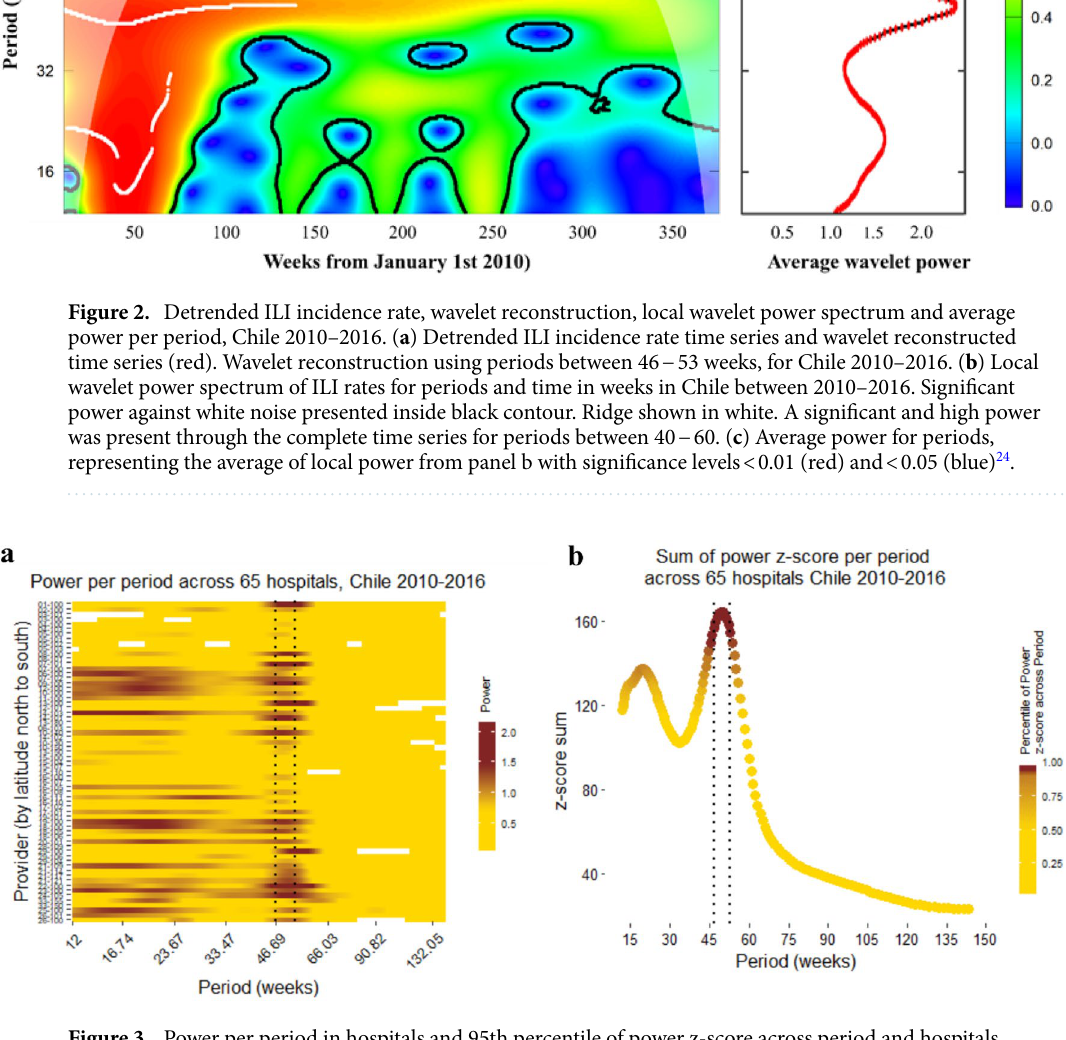
Figure 3. Power per period in hospitals and 95th percentile of power z-score across period and hospitals, Chile 2010–2016. ( a ) Power per each of the 65 hospitals presented across periods. Dark red represent higher power, yellow represents low power and fit, white spaces denote non-significant power compared to white noise. ( b ) Cumulative power z-score to calculate the periods with best fit across hospitals, represented as the 95th percentile of cumulative power. Power for each hospital were normalized, log transform, subtracted from the mean, and divided by the standard deviation. The sum of z-score for each period was plotted with the 95th percentile (dotted lines in both a and b ) 24,27